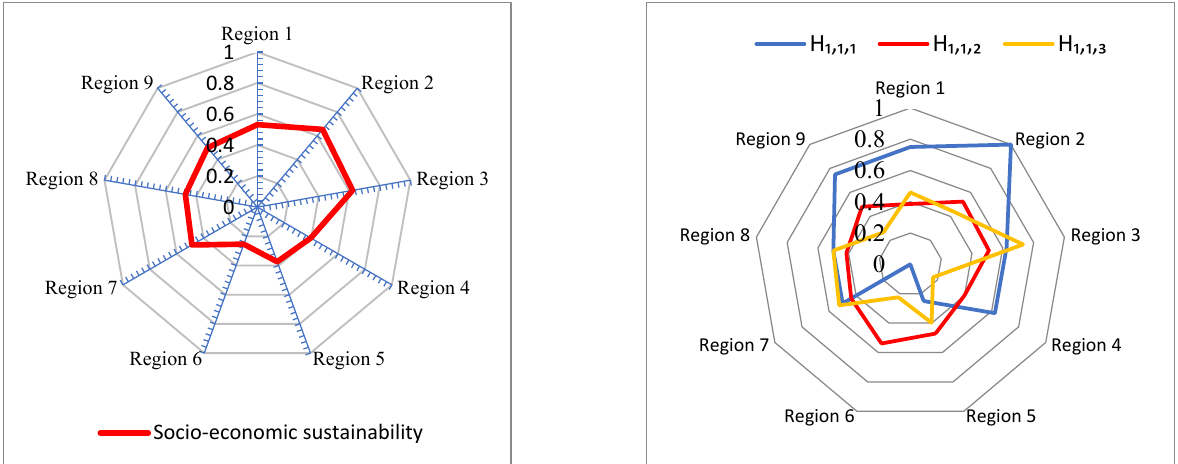
Figure 9. Socioeconomic evaluation of the 9 regions: H 1,1,1 (safety and security), H 1,1,2 (demographic characteristics and social welfare), and H 1,1,3 (infrastructure and urban Services).